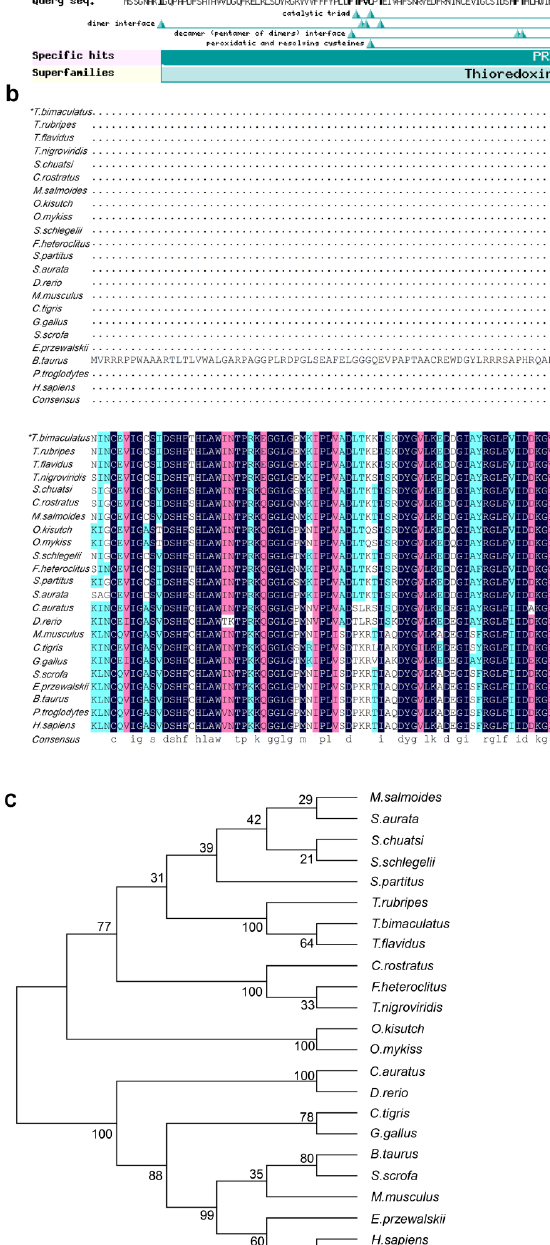
Figure 2. ( a ) Structural domain prediction for Tbprx-1. ( b ) Alignment of prx-1 in Takifugu bimaculatus with those from other species. Multiple sequence alignment of Tbprx-1 (TNM85992.1) and T. flavidus (TWW58563.1), Takifugu rubripes (XP_003972530.1), Tetraodon nigroviridis (ABC59169.1), Siniperca chuatsi (XP_044045544.1), Chelmon rostratus (XP_041819927.1), Micropterus salmoides (XP_038570209.1), Gallus (NP_001258861.1), Homo sapiens (NP_001189360.1), Danio rerio (NP_001013489.2), Bos taurus (NP_776856.1), Pan troglodytes (XP_001156568.1), Sus scrofa (XP_020952401.1), Crotalus tigris (XP_039205522.1), Equus przewalskii (XP_008519794.1), Oncorhynchus kisutch (XP_020309895.2), Oncorhynchus mykiss (XP_021412501.2), Carassius auratus (XP_026051992.1), Sebastes schlegelii (QGN18756.1), Fundulus heteroclitus (XP_012725625.2), Stegastes partitus (XP_008276119.1), Mus muscu- lus (NP_035164.1) and Sparus aurata (XP_030284090.1). * indicate species in this study. ( c ) Phylogenetic tree constructed based on the deduced amino acid sequence of Tbprx1 and other genes of the perox- iredoxin (PRX) superfamily using the neighbor-joining